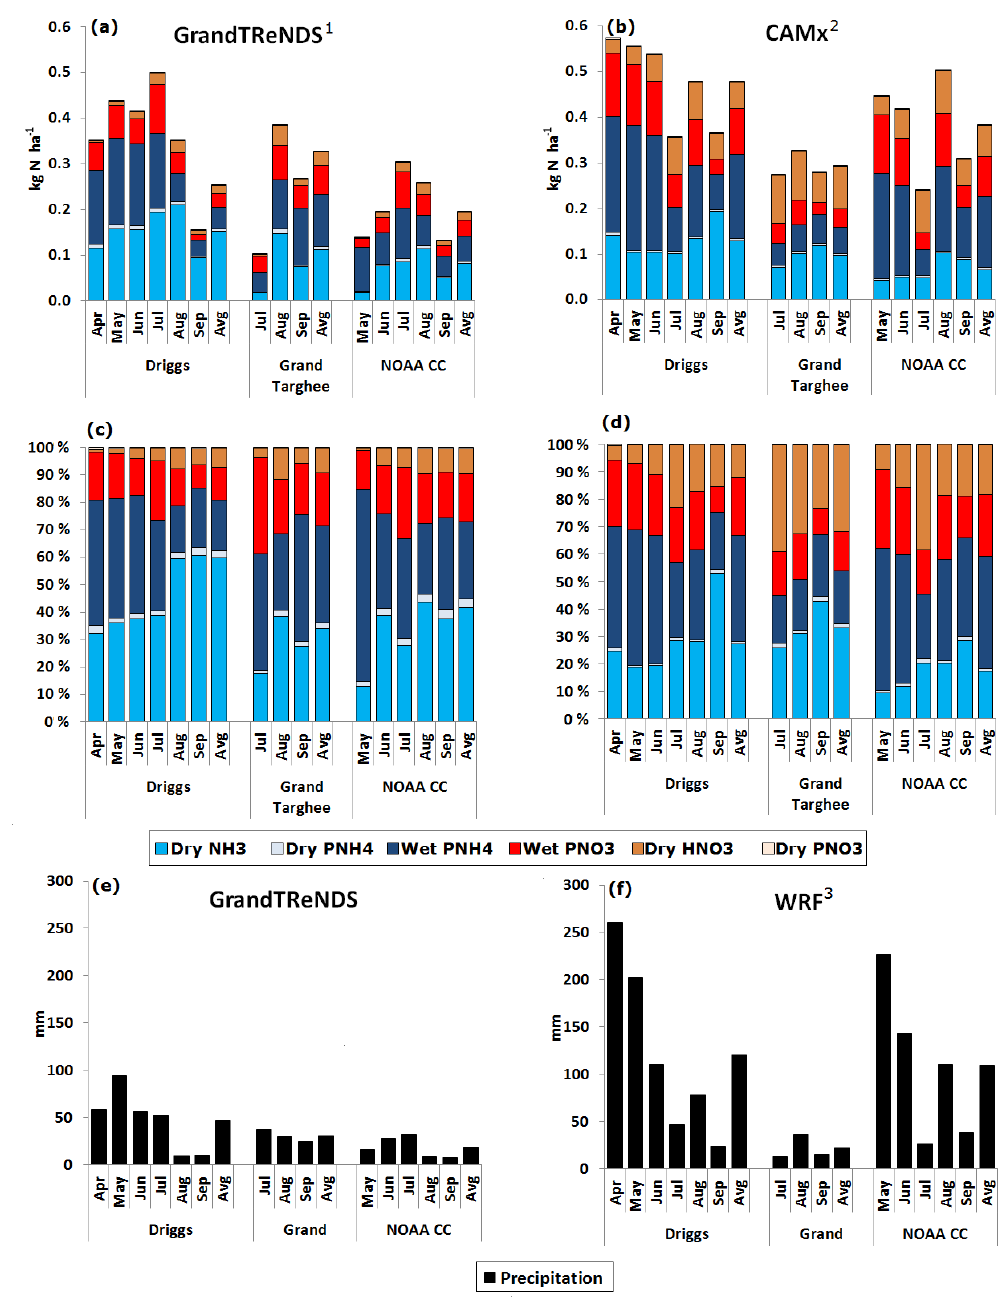
Figure 4. Inorganic nitrogen deposition budgets as an absolute (a) and as a percentage (c) as well as precipitation (e) , measured at the three core sites during the GrandTReNDS study period (April to September in 2011) with corresponding CAMx simulations (b, d, e) . 1 Grand Teton Reactive Nitrogen Deposition Study. 2 Comprehensive Air Quality Model with extensions. 3 Weather Research and Forecasting